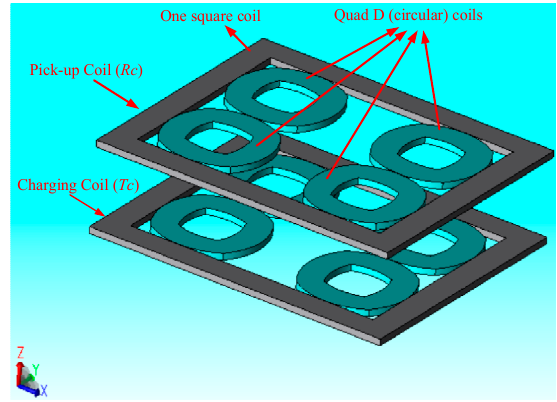
Figure 1. Quad D Quadrature (QDQ) coil design model in JMAG software (version 14.0, JSOL Corporation, Tokyo, Japan).